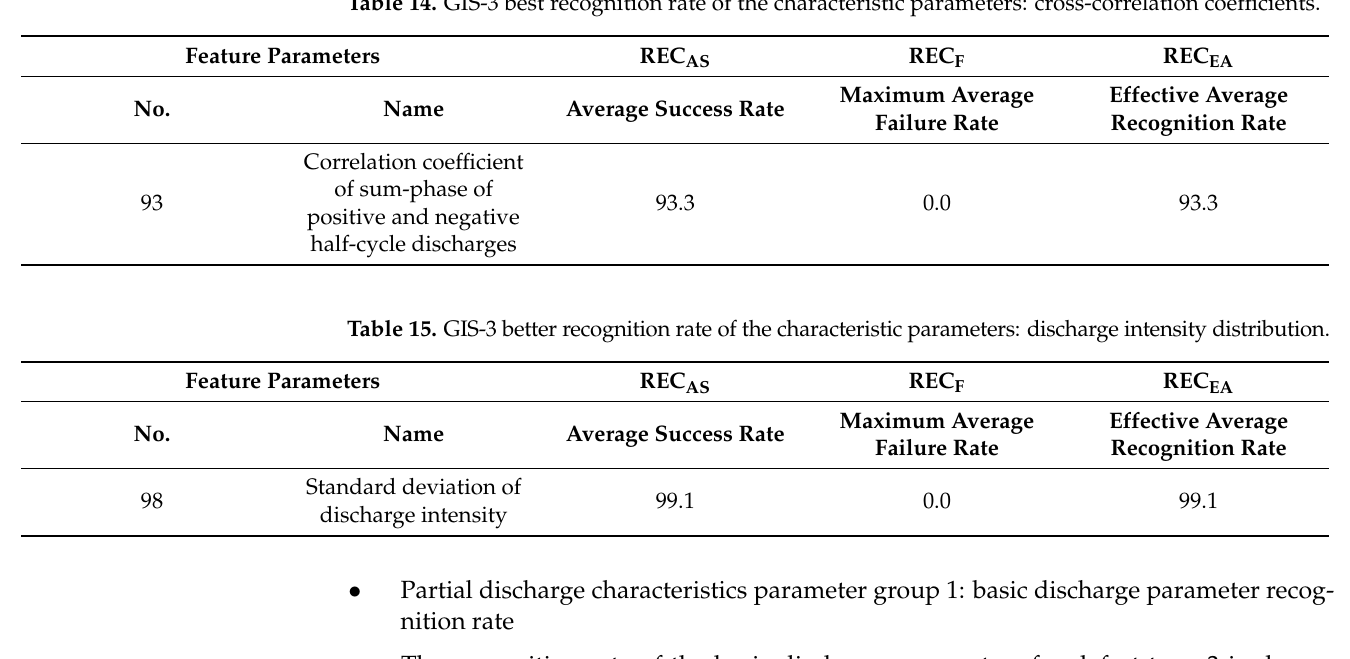
Table 14. GIS-3 best recognition rate of the characteristic parameters: cross-correlation coefficients.